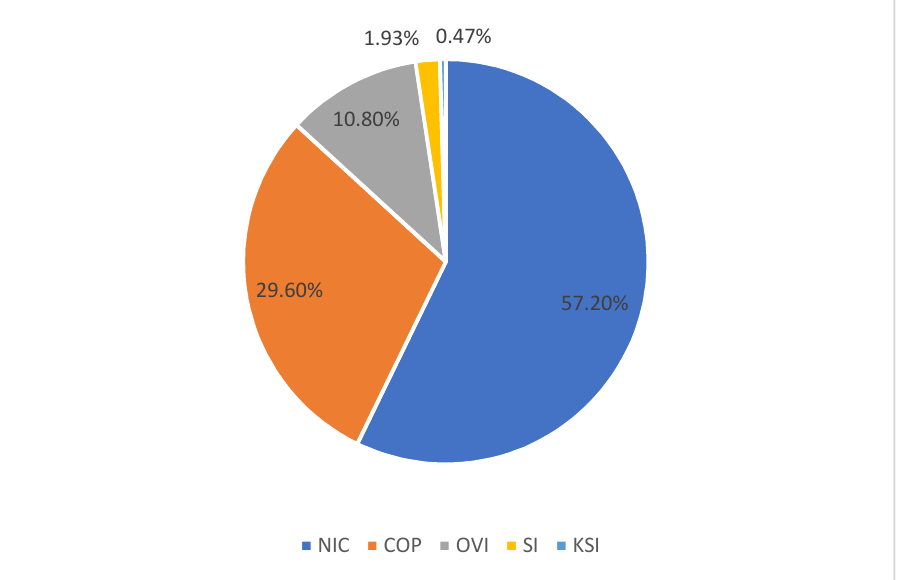
Figure 1. The proportion of crash injury severity in data. NIC—non-injury crash; COP—complaint of pain; OVI—other visible injury; SI—severe injury; KSI—killed.